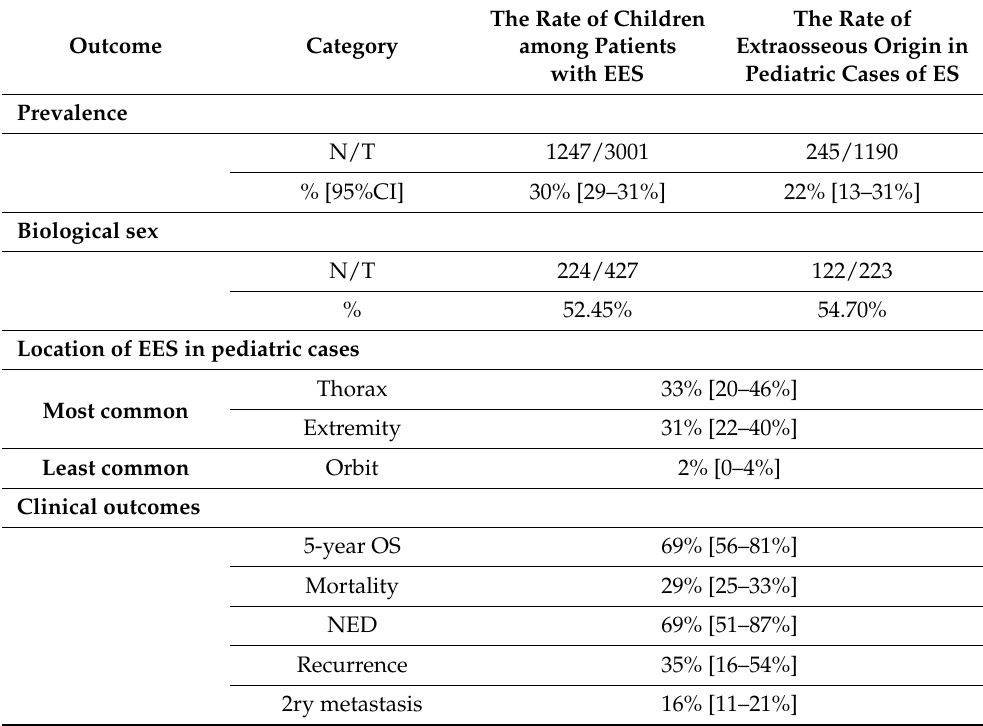
Table 6. Summary of the key findings on the pediatric EES cases in our review. Outcome Category